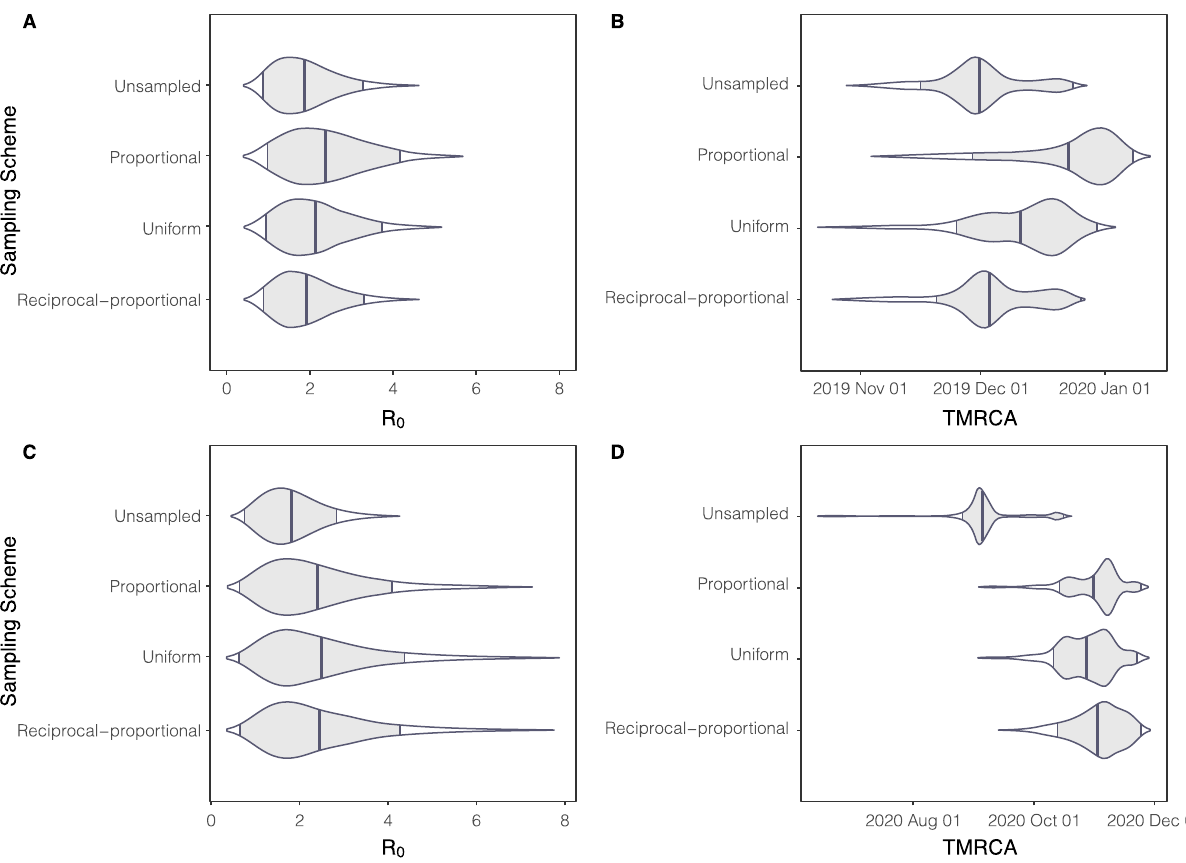
Fig. 3 | R 0 estimated from BDSKY (using sequence data) and TMRCA for Hong Kong and Brazil. A , B Represent Hong Kong and C , D represent the Amazonas State, Brazil. The central line represents the posterior mean and with intervals representing 95% highest posterior density